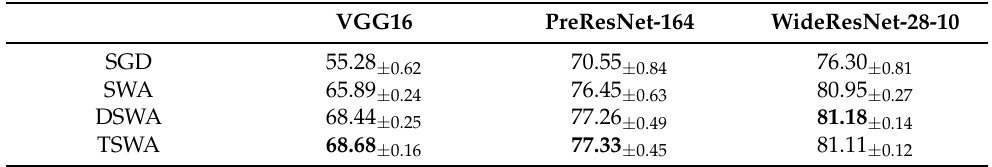
Table 5. Test accuracy (%) comparison among SGD, SWA, DSWA, and TSWA on CIFAR-100. The SGD procedure that processed before SWA does not converge. Best results are bolded